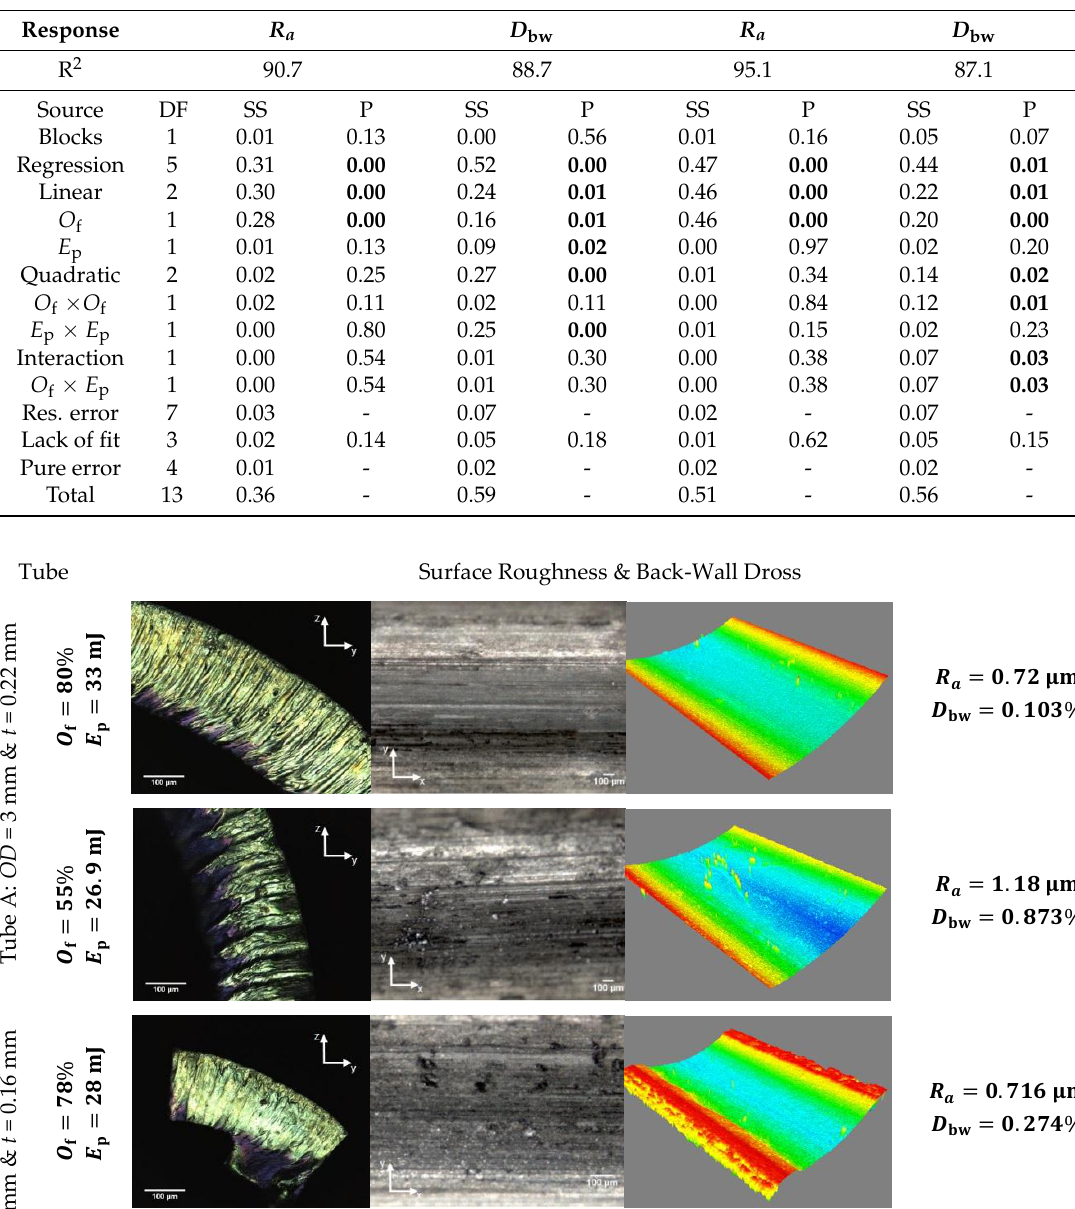
Table 8. ANOVA results for surface response methodology without gas blowing through the tube. Tube